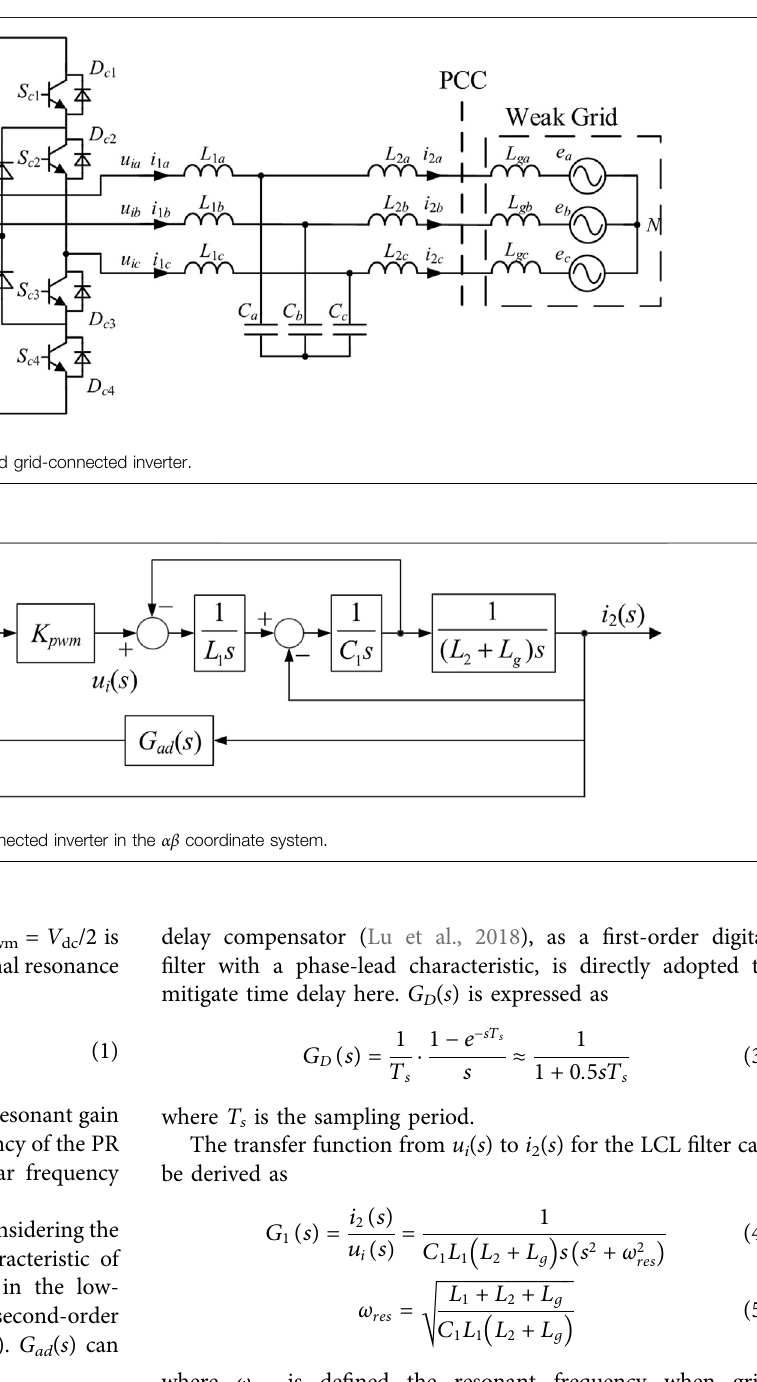
Frontiers in Energy Research |